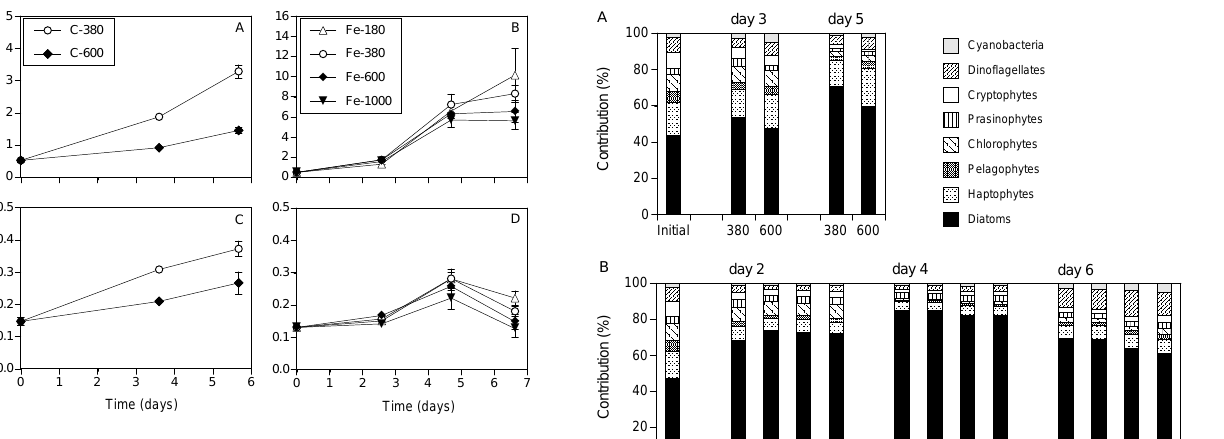
Figure 1. Temporal changes in fucoxanthin (a, b) and 19 (cid:48) - hexanoyloxyfucoxanthin (c, d) concentrations. Graphs on the left and right sides indicate data from the control and Fe-added treat- ments, respectively. Error bars denote ± 1 standard deviation (SD, n = 3). Standard deviations were not assessed on days 2 (Fe-added treatments) and 3 (control treatments) because samples were col- lected from each single bottle.